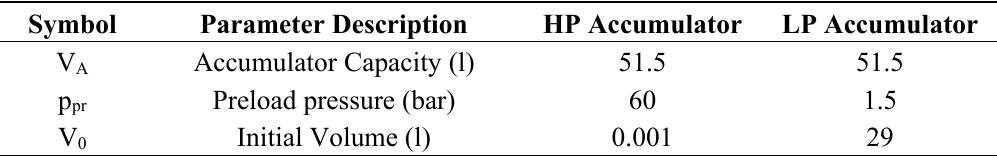
Table 6. Parameters of pre-charged gas accumulators.